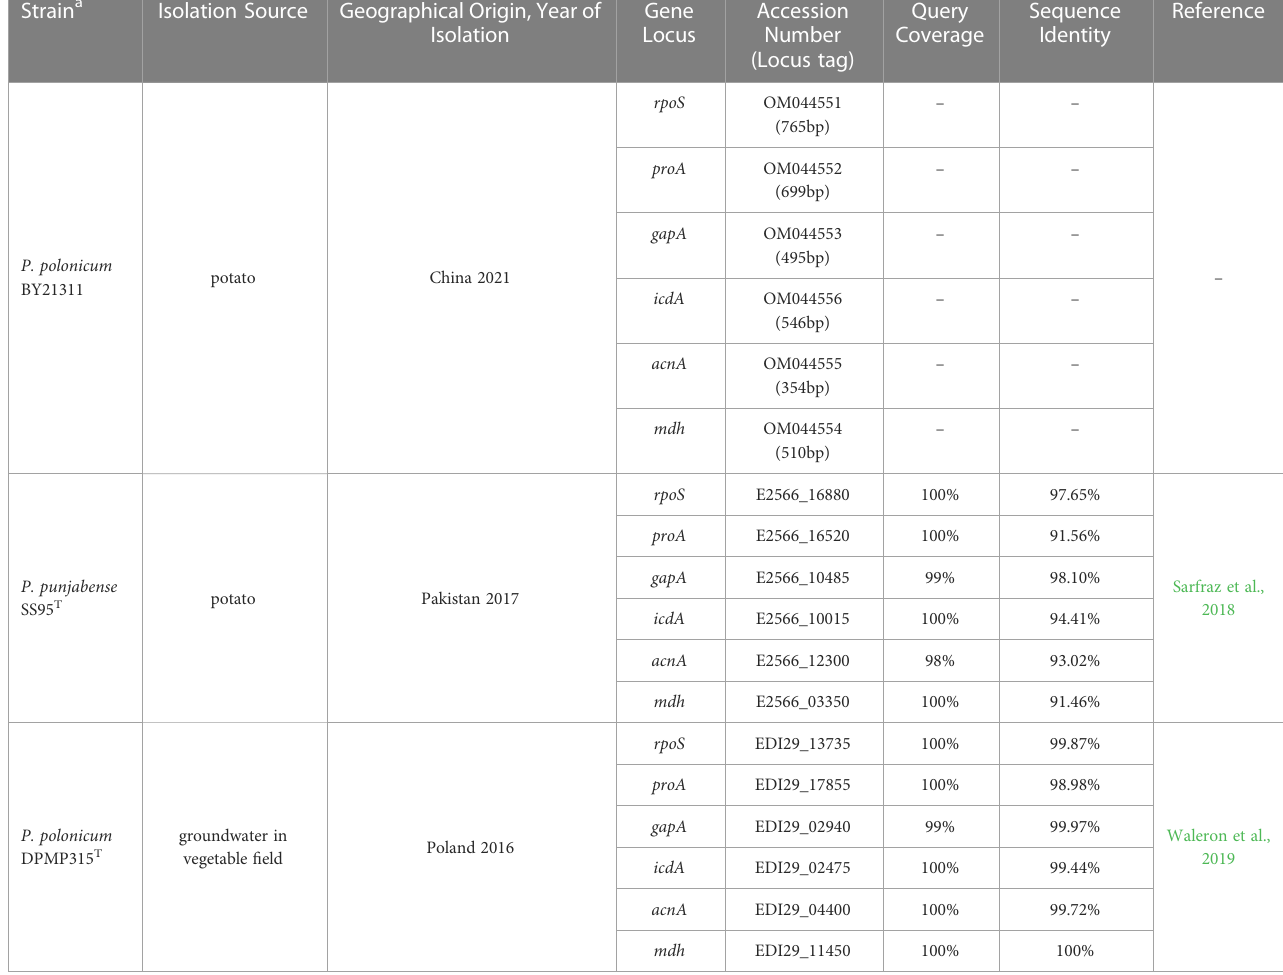
TABLE 1 BLASTn results of MLSA sequences of Pectobacterium isolate BY21311 to P. polonicum and P. punjabense . Strain